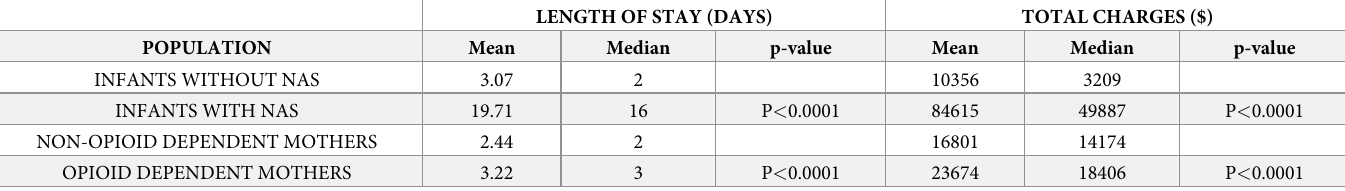
Table 1. Comparison of hospital utilization variables in the target versus non-target populations and results of the t-test analyses. LENGTH OF STAY (DAYS) TOTAL CHARGES ($) POPULATION Mean Median p-value Mean Median p-value INFANTS WITHOUT NAS 3.07 INFANTS WITH NAS 19.71 P < 0.0001 NON-OPIOID DEPENDENT MOTHERS OPIOID DEPENDENT